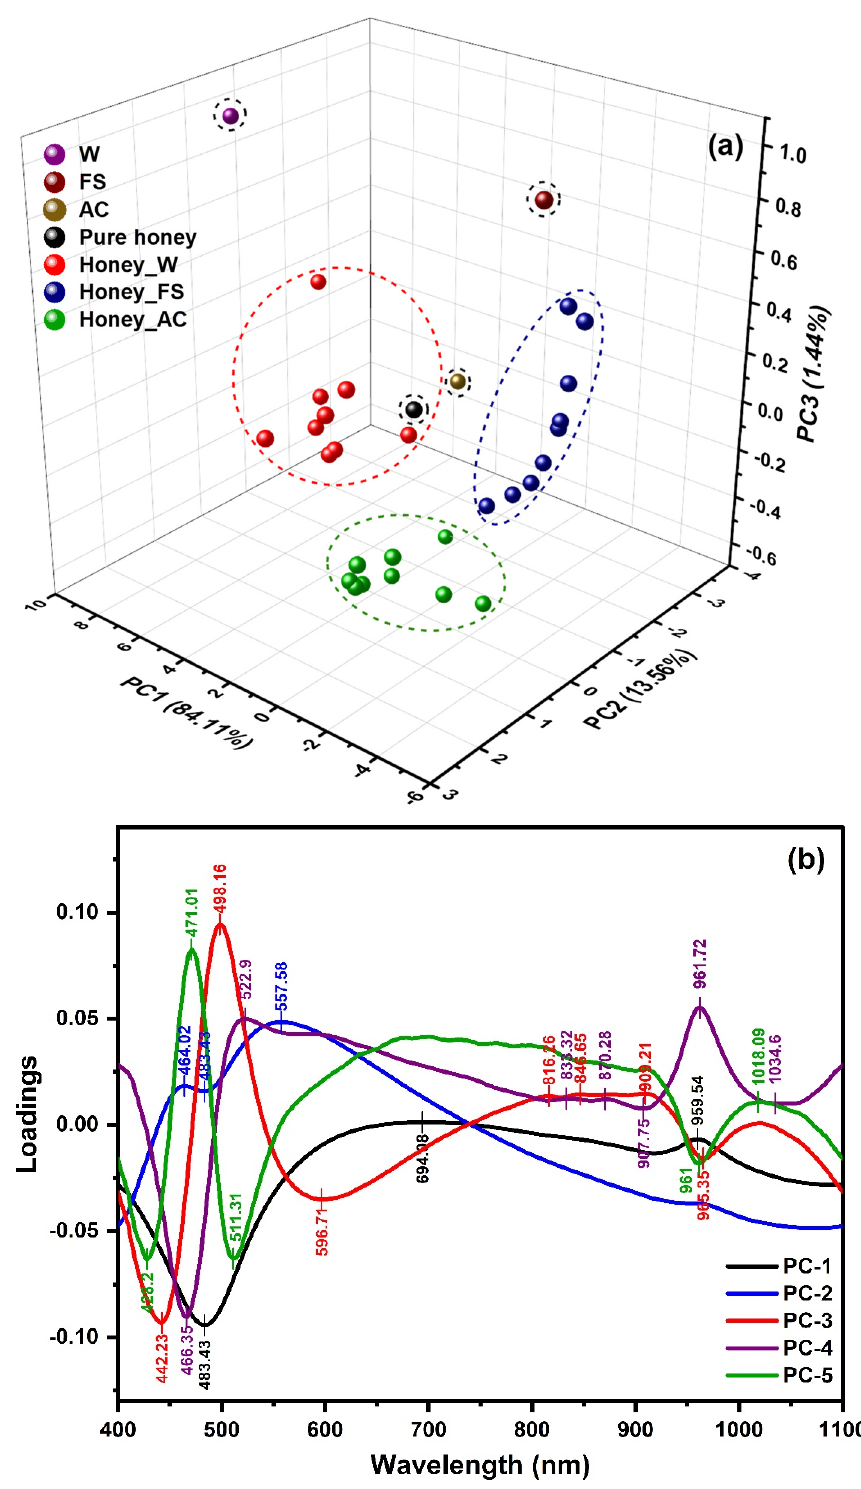
Figure 6. PCA analysis: ( a ) 3D score plot of the first three PCs and ( b ) x-loadings of PC1-PC5 of Vis-NIR spectra (400–1100 nm).